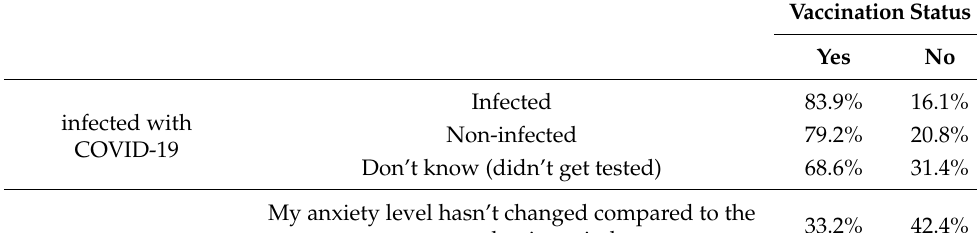
Table 2. The relationship between being infected with COVID-19, anxiety experienced during the pandemic, ability to cope with thoughts about COVID-19, effect of the pandemics on young people’s expectations for their futures, accessing healthcare services, receiving accurate and sufficient information on proposed vaccines, information from the MoH and the scientific committee and being